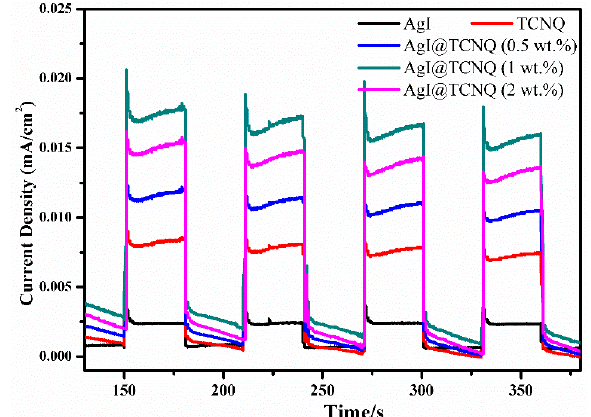
Figure 5. Transient photocurrent responses of as-prepared composites.